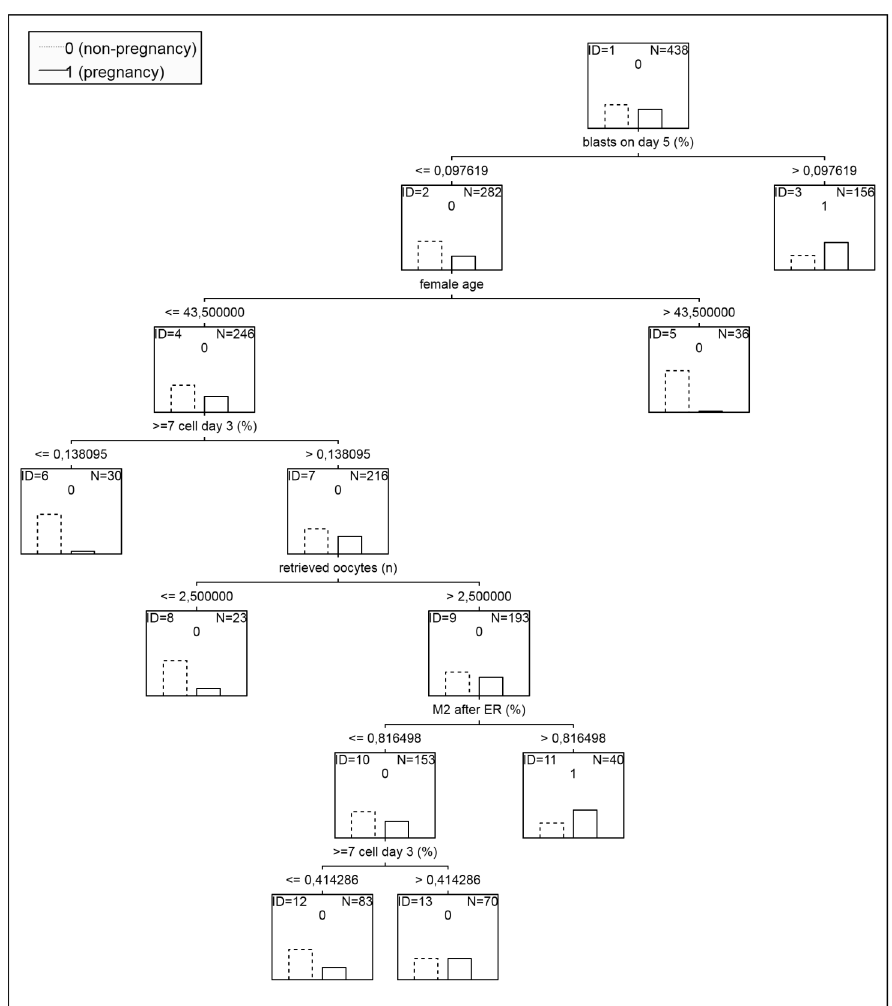
Figure 1. Classification tree constructed for all variables (the information about women’s age, oocytes, embryos and transfer) ter ER (%) (importance = 0.52). For tree 1, only two leaf nodes were char- acterized by a predominance of pregnancies. The first leaf node (ID =